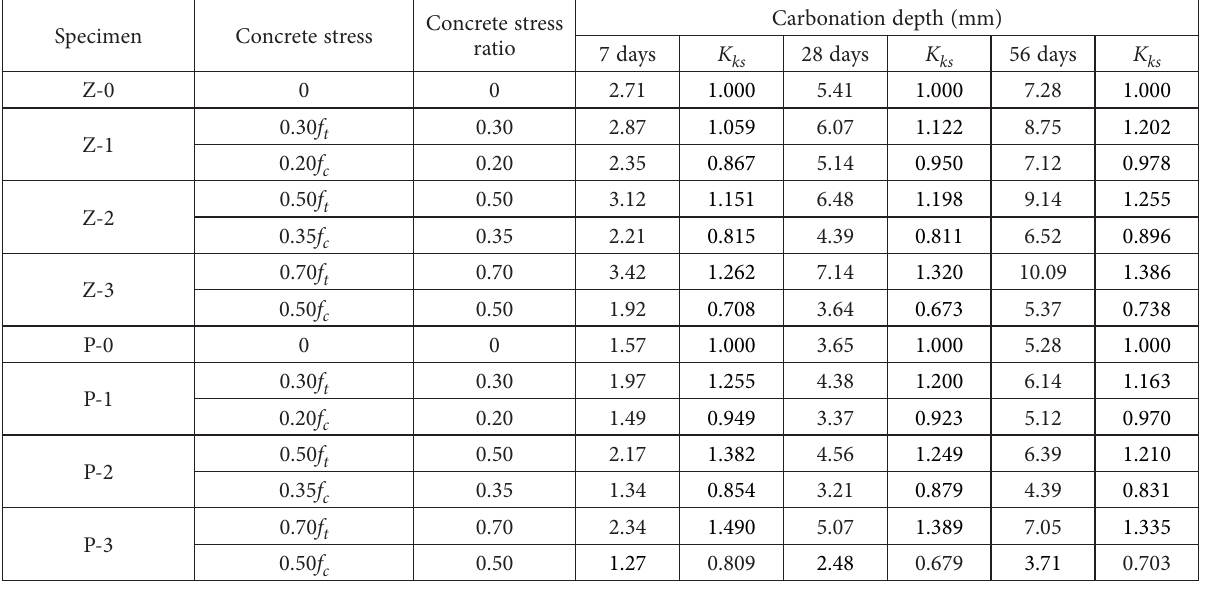
Table 7. Carbonation depths of specimens under different concrete stress conditions (data from Wang, 2012)